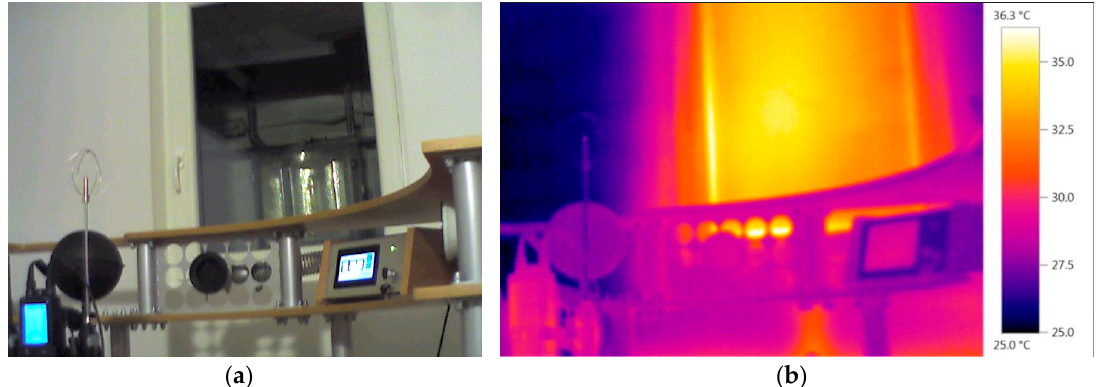
Figure 13. ( a ) Normal and ( b ) infrared photo of the window in the test room.